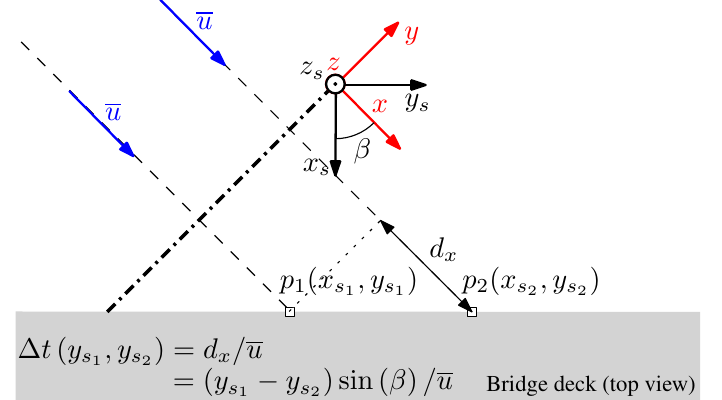
) between points located at p 1 and p 2 for a incoming frozen turbulent Figure 1. Time delay ∆ t ( y s , y s 2 1 flow with a yaw angle β and a mean wind speed u . The x and y axis are the horizontal axes and z is the positive vertical